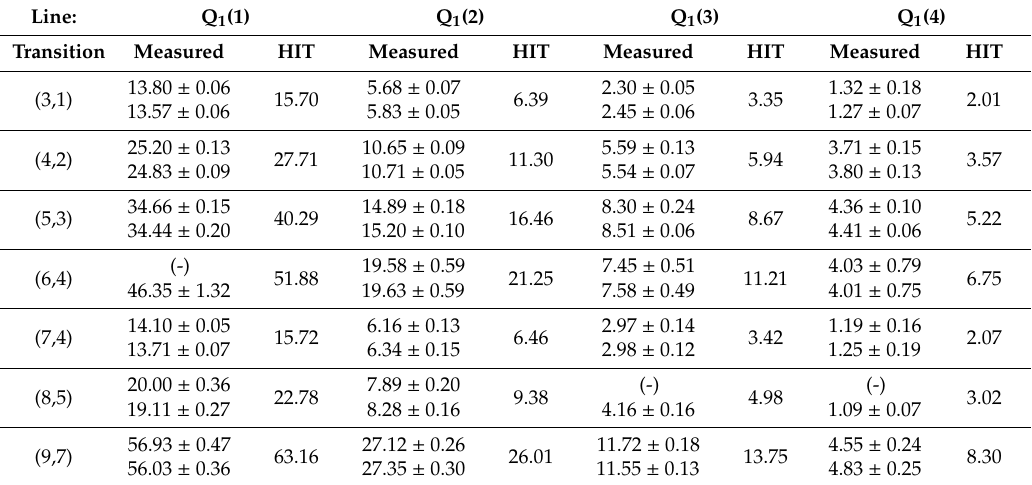
Table 1. Einstein transition probabilities for the spontaneous emission of the first four Q-branch lines of the vibrational transitions. Each value is given for the direct line ratio method (upper entry) and the spectral fit method (lower entry). Values which could not be calculated are marked as (-). The measured values are given with their respective errors of one standard error of the mean and the HITRAN (HIT) value for comparison. All numbers are in units of s − 1